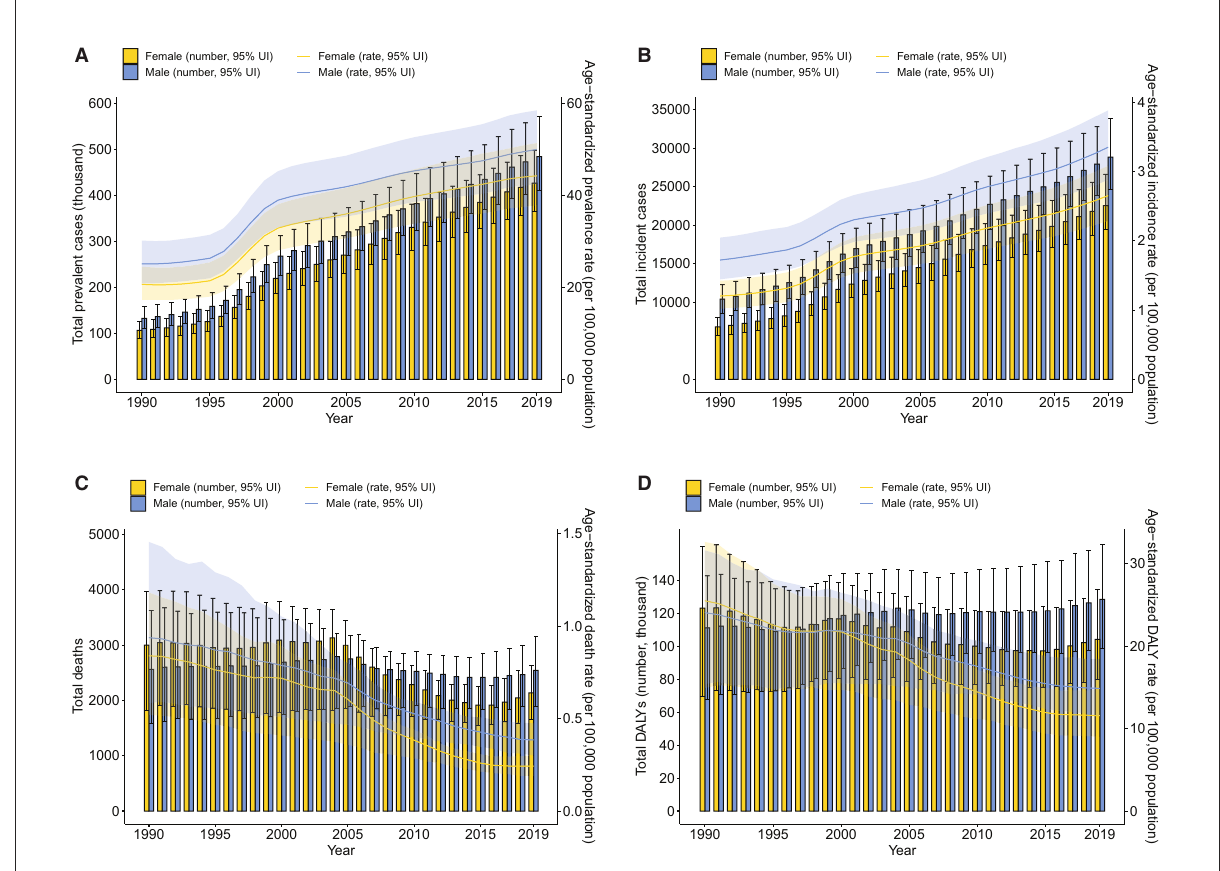
FIGURE1 Trends from 1990 to 2019 in number and age-standardized rates of prevalence (A) , incidence (B) , deaths (C) , and DALYs (D) of IBD by sex in China. Error bars indicate the 95% uncertainty interval (UI) for the number of each measure. Shading indicates the 95% UI for the age-standardized rates. DALYs, disability-adjusted life-years; IBD, inflammatory bowel